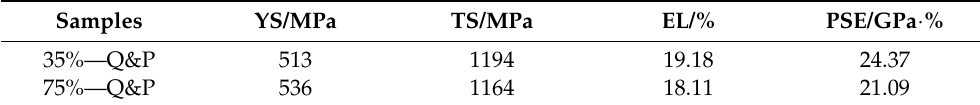
Figure 7. The engineering stress–strain plots of 35%−Q&P sample and 75%−Q&P sample. Table 1. The yield strength (YS), tensile strength (TS), total elongation (EL), and product of strength and elongation (PSE) of 35%−Q&P sample and 75%−Q&P sample. Samples